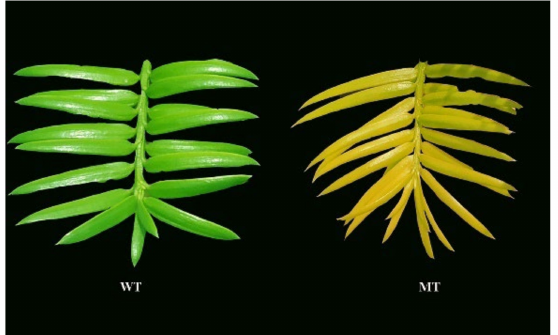
Figure 1. Branches of mutant-type and wild-type Torreya grandis ‘Merrillii’. (WT means wild type; MT means mutant-type yellow